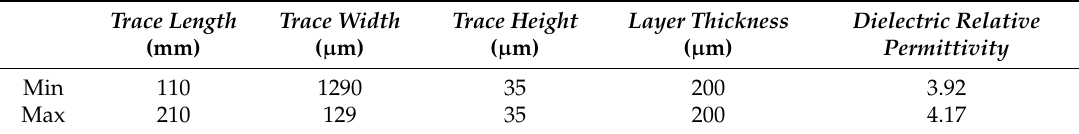
Figure 7. Computed scattering parameters for the PCB traces: ( a ) transmission parameters along trace #13; and ( b ) transmission parameters from trace #13 to traces #14 and #15. Table 4. Geometrical and physical parameters for the PCB.